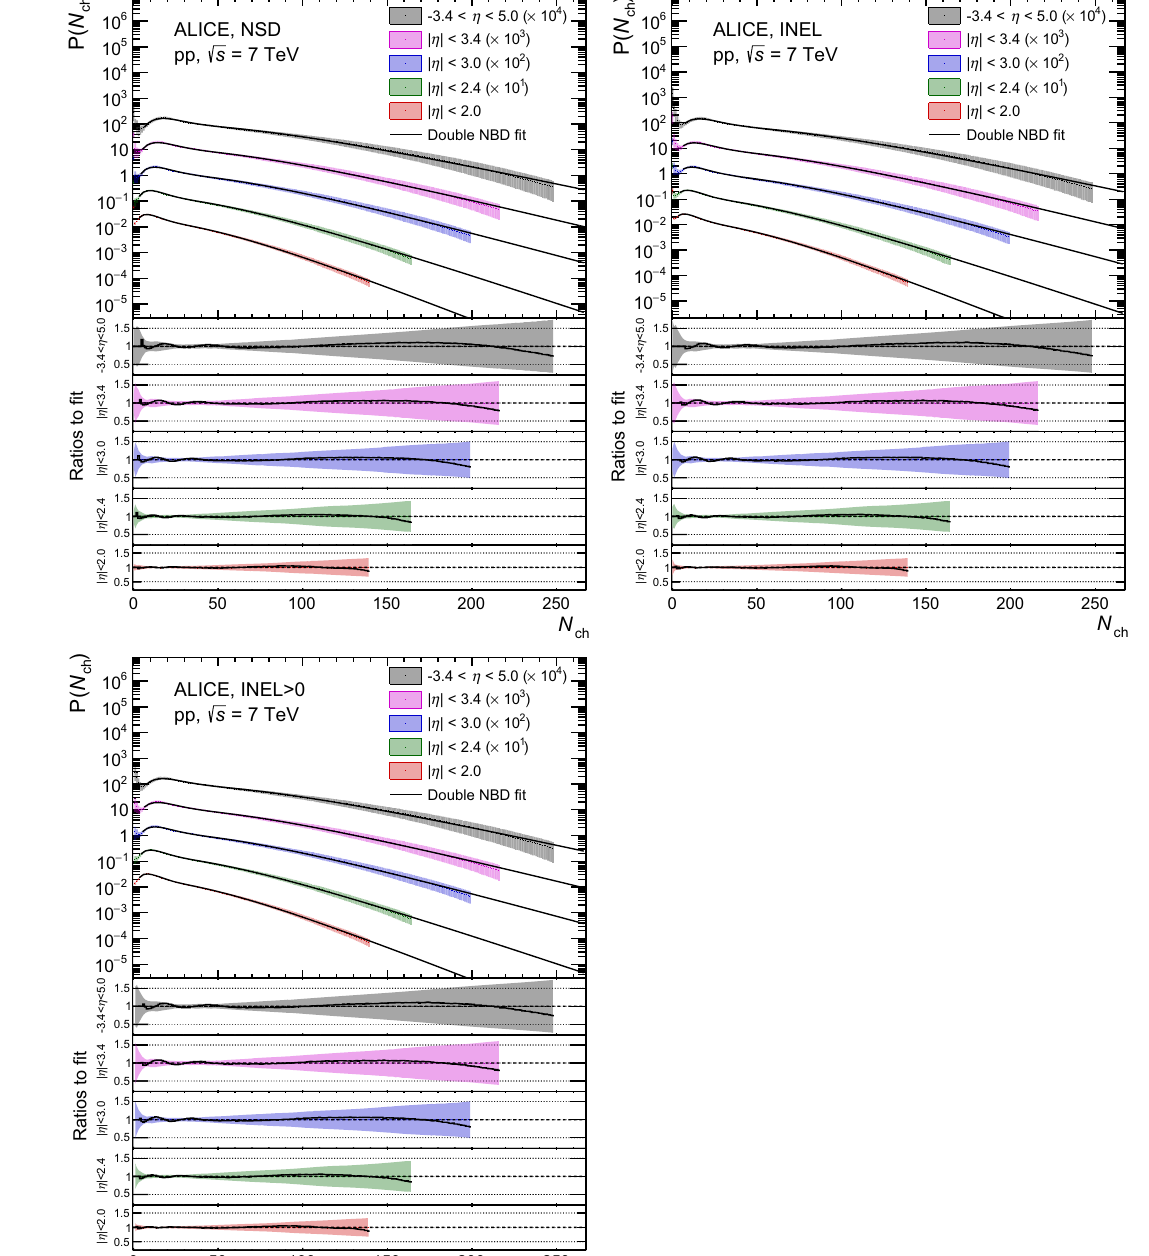
Fig. 4 Charged-particle multiplicity distributions for NSD (top left), INEL (top right) and INEL > 0 (bottom) pp collisions at The lines show fits to double NBDs. Ratios of the data to the fits are also